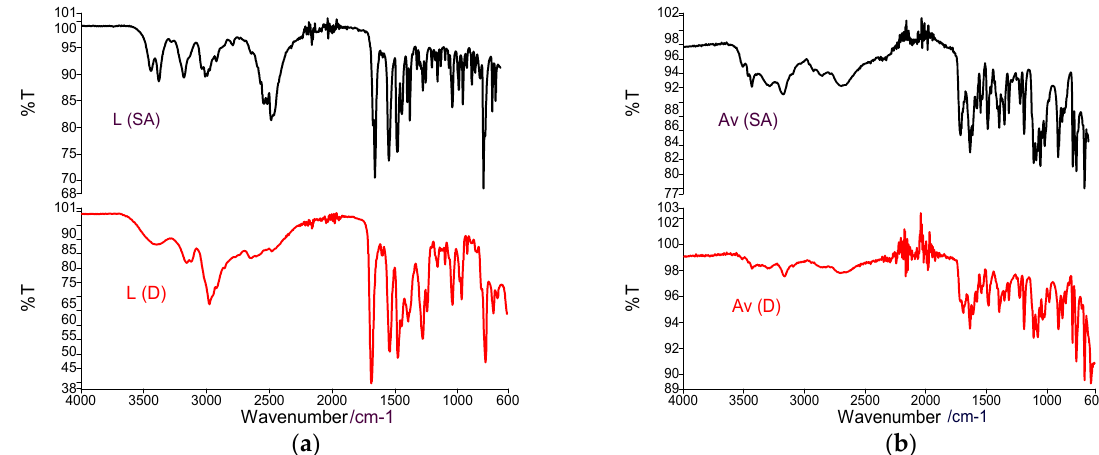
Figure 2. ( a ) FTIR spectra of Lidocaine L (SA))/Lidocaine dissolved L (D); ( b ) FTIR spectra of Acyclovir Av (SA) and Acyclovir Av (D).